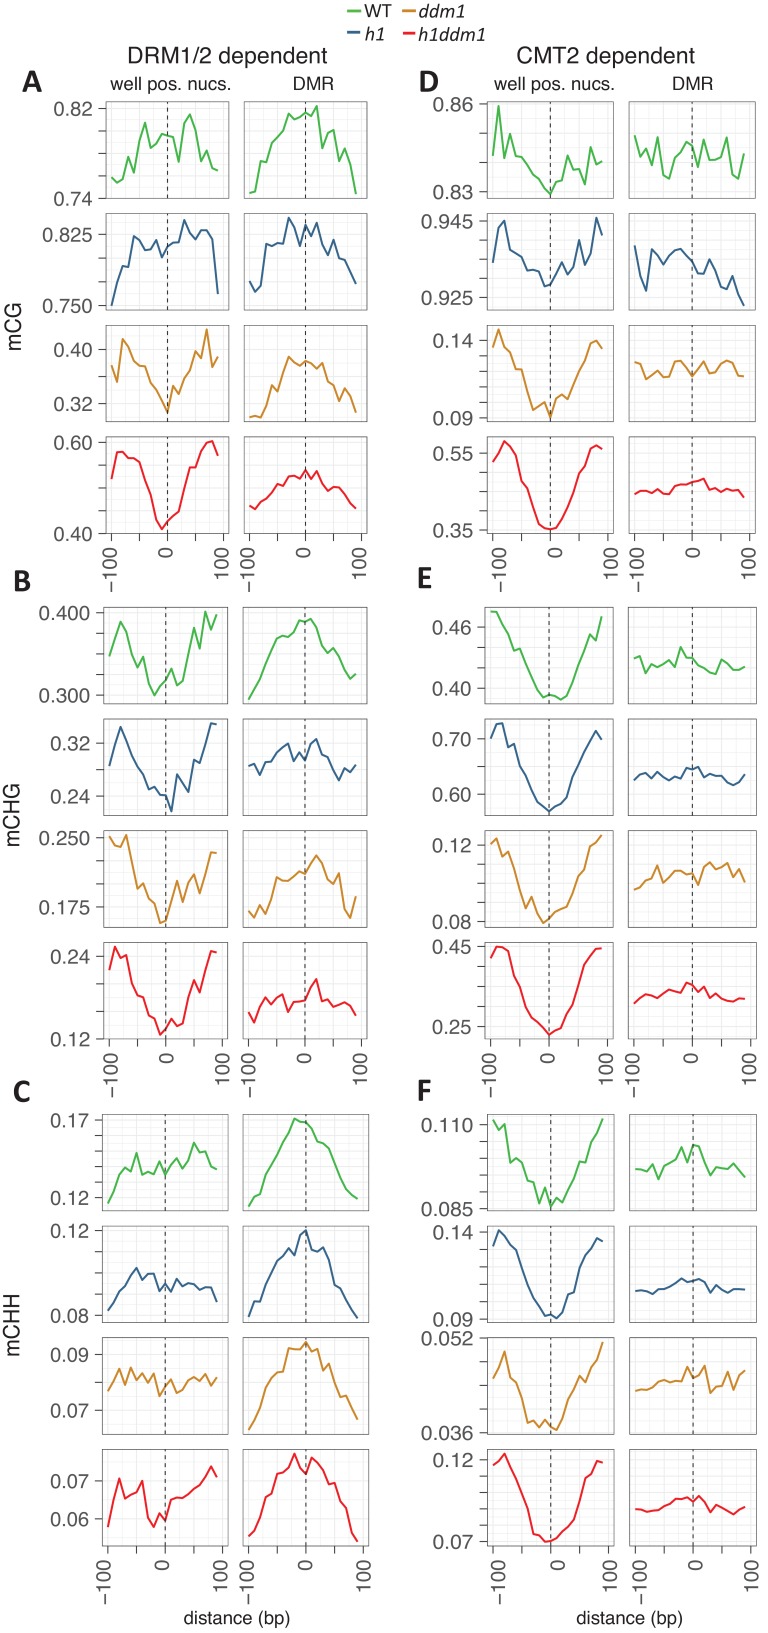
Zoomed-in view of DNA methylation around nucleosomes at DRM- or CMT2-dependent loci.Methylation is plotted exactly as described for Figure 2, with DMRs of DMR1/2 on the left (A–C) and CMT2 on the right (D–F). Axes adjusted to enable visualization of nucleosome core depletion.